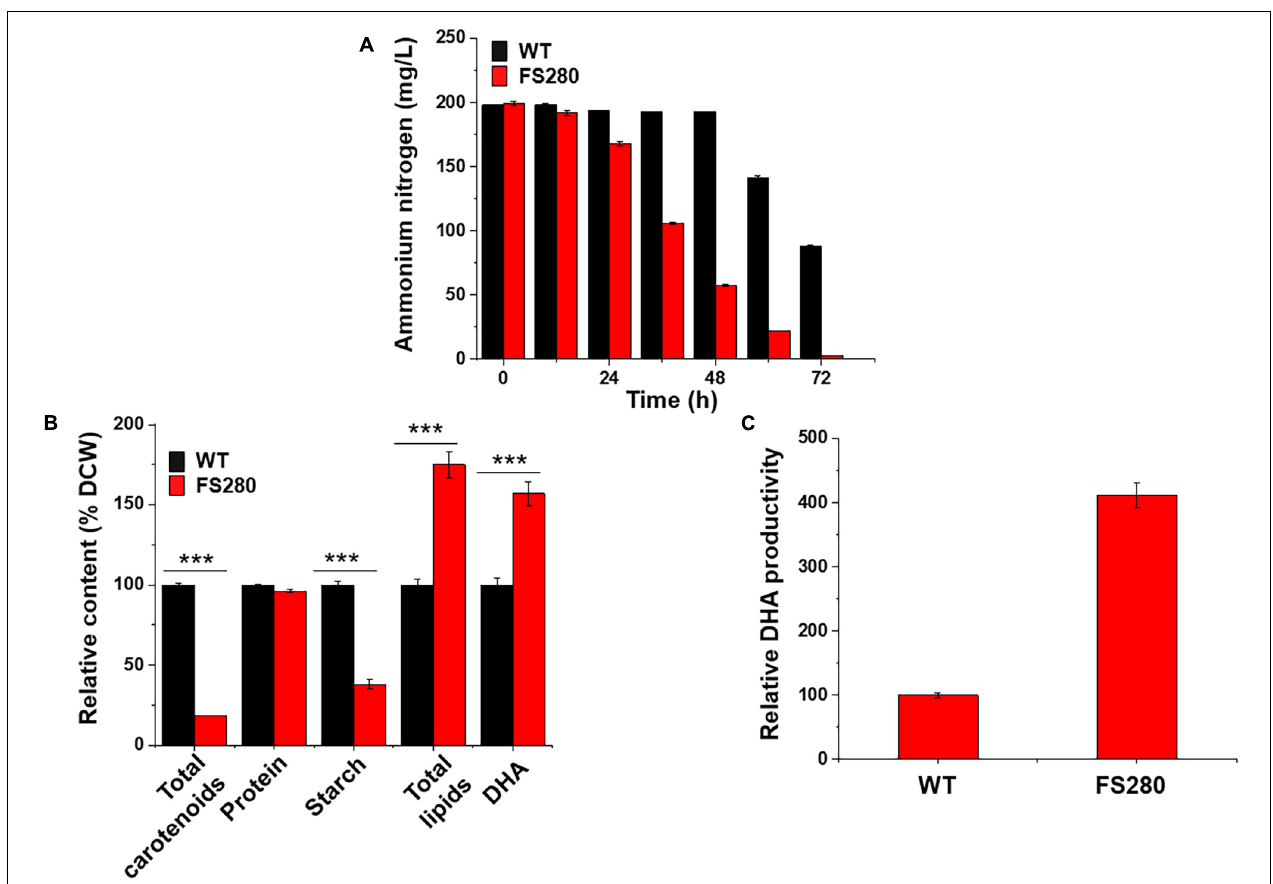
FIGURE 2 | Comparative characterization between FS280 and WT in the presence of 90% ( v/v ) fermentation supernatant. (A) The changes in the ammonium nitrogen concentration over 72 h. (B) Relative content of cell components at 72 h: DCW, dry cell weight. (C) Relative DHA productivity at 72 h (the biomass was expressed by OD 490 ). ** p < 0.01 and *** p <